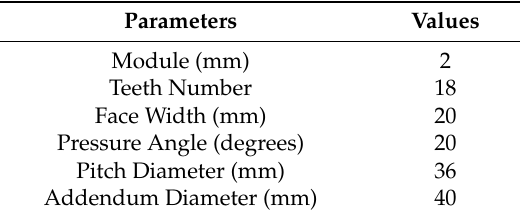
Figure 4. ( a ) Photo of the 18-tooth spur gear; ( b ) projected moiré fringes on the gear tooth surface. Table 2. Design parameters of the measured spur gear.